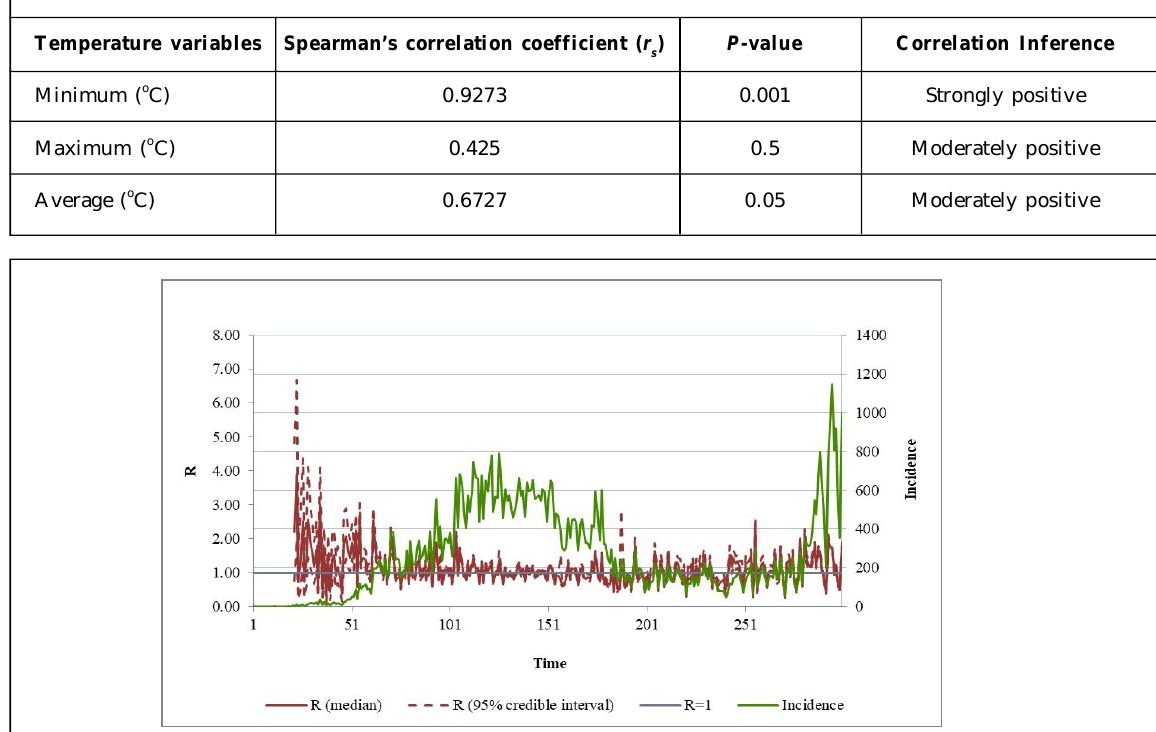
Table 2: Relationship between R and temperature variables